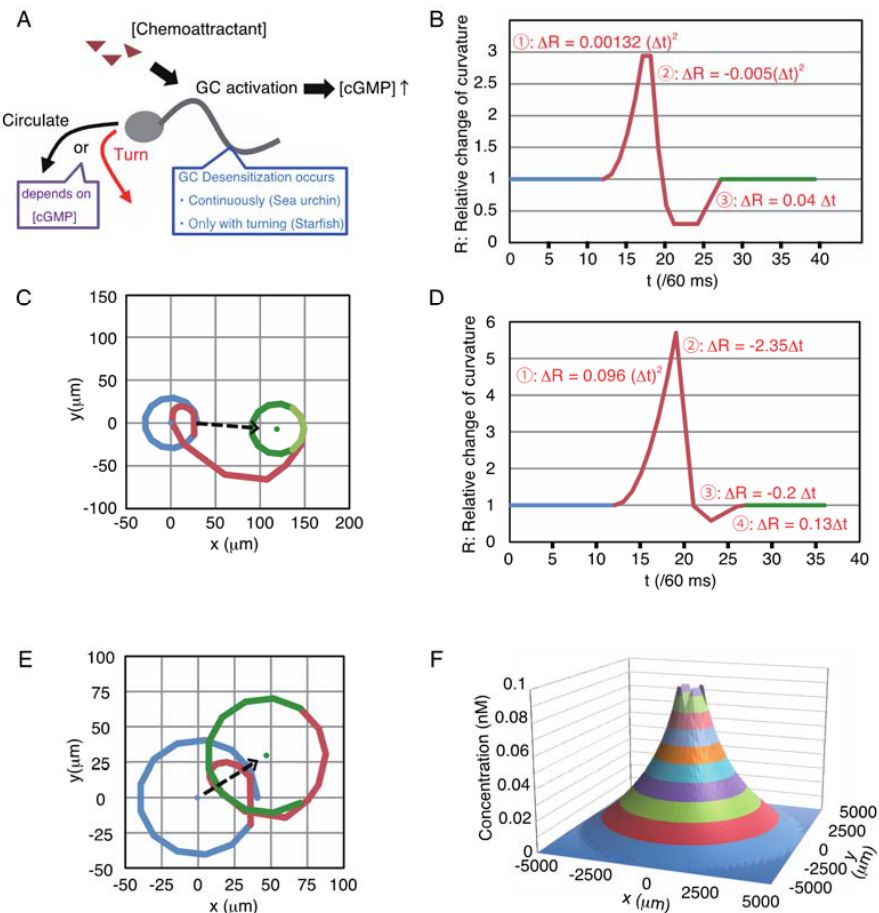
Figure 1. Design of sperm models. ( A ) Conceptual diagram of modeled sperm. Sperm movement was chosen between the circular motion and turn, depending on (Chemoattractant) and (GC). B and D: Sperm curvatures of sea urchin ( B ) and starfish ( D ) in turn mode. The y -axis indicates the curvature in relative change to the circular-motion mode. The x -axis is a time series in 60 ms frames. C and E: Sperm movement pattern of turn mode in the sea urchin model ( C ) and starfish model ( E ). The colors of the tracks correspond to the colors of lines B and D. ( F ) An example of the shape of the (Chemoattractant) gradient defined within a radius of 5000 µ m. The z -axis indicates (Chemoattractant) at each point calculated in the 2D surface represented as an x-y plane, where the egg is located at the origin with (Chemoattractant)s = 0.1